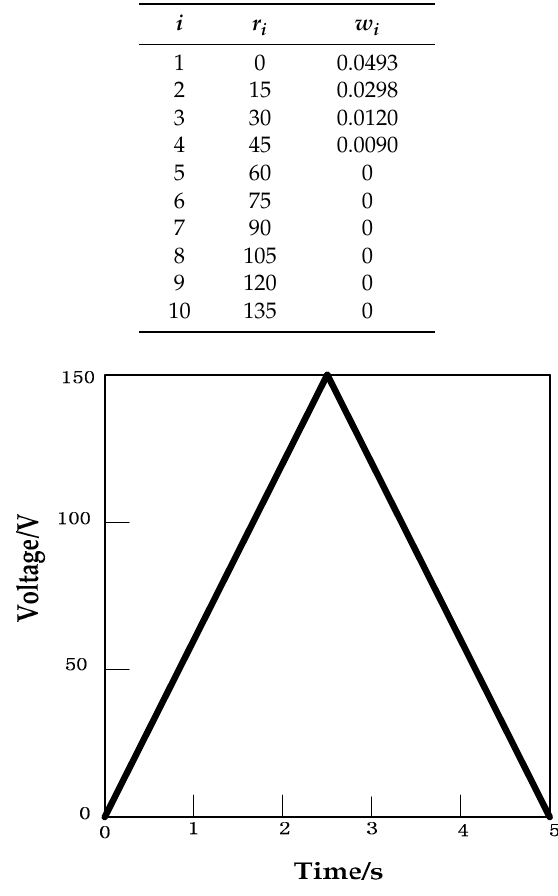
Table 1. Parameters of the Prandtl–Ishlinskii (PI) model. ( i is the number of sampling point, r i is the threshold of the play operator, w i is the weight of each hysteresis operator in the mathematical sense).